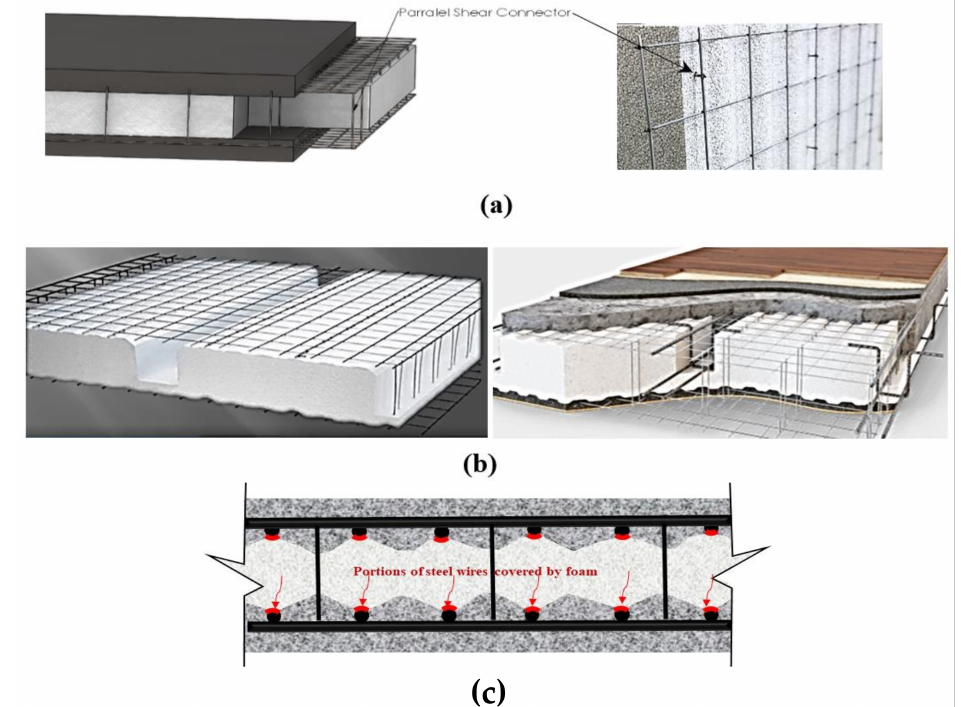
Figure 5. CPS Panels Shear Reinforcements: ( a ) Panels with parallel wires shear reinforcement ( Class I ), ( b ) Ribbed floor panels with parallel wires shear reinforcement ( Class II ), ( c ) Portions of wire surfaces covered by EPS